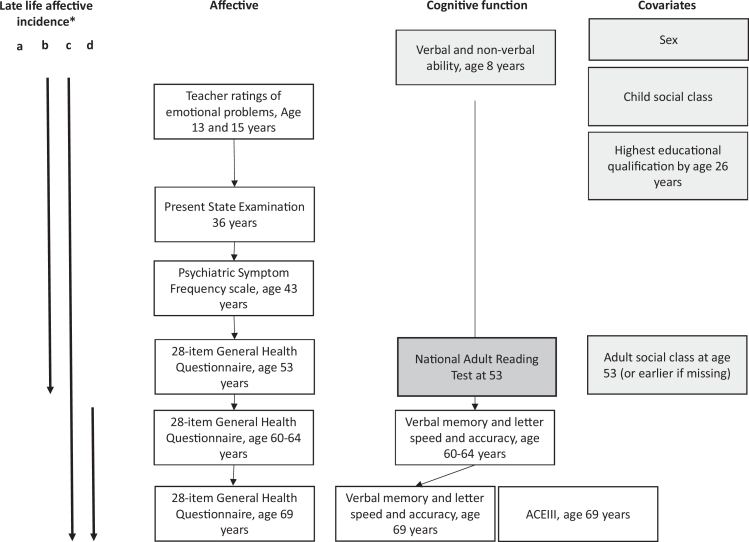
Flow diagram for MRC National Survey of Health and Development data used in this study*.Grey boxes = additional adjustments in model 2, Dark grey = additional adjustments in model 3. *Late-life incidence categories (a) Never case-level (b) Case-level in earlier-life only (age ≤ 53) (c) Case-level incidence in later-life (age ≥ 60) and in earlier-life (age ≤ 53) (d) first incidence of case-level in late-life (age ≥ 60).